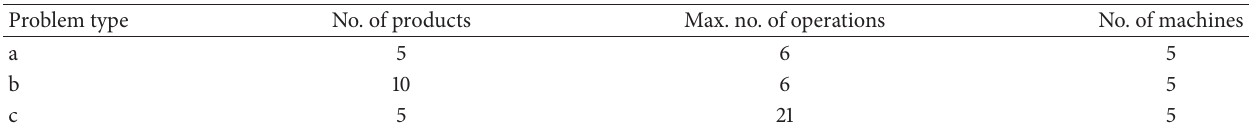
Figure 3: Gantt chart of this example. Table 2: Data set.